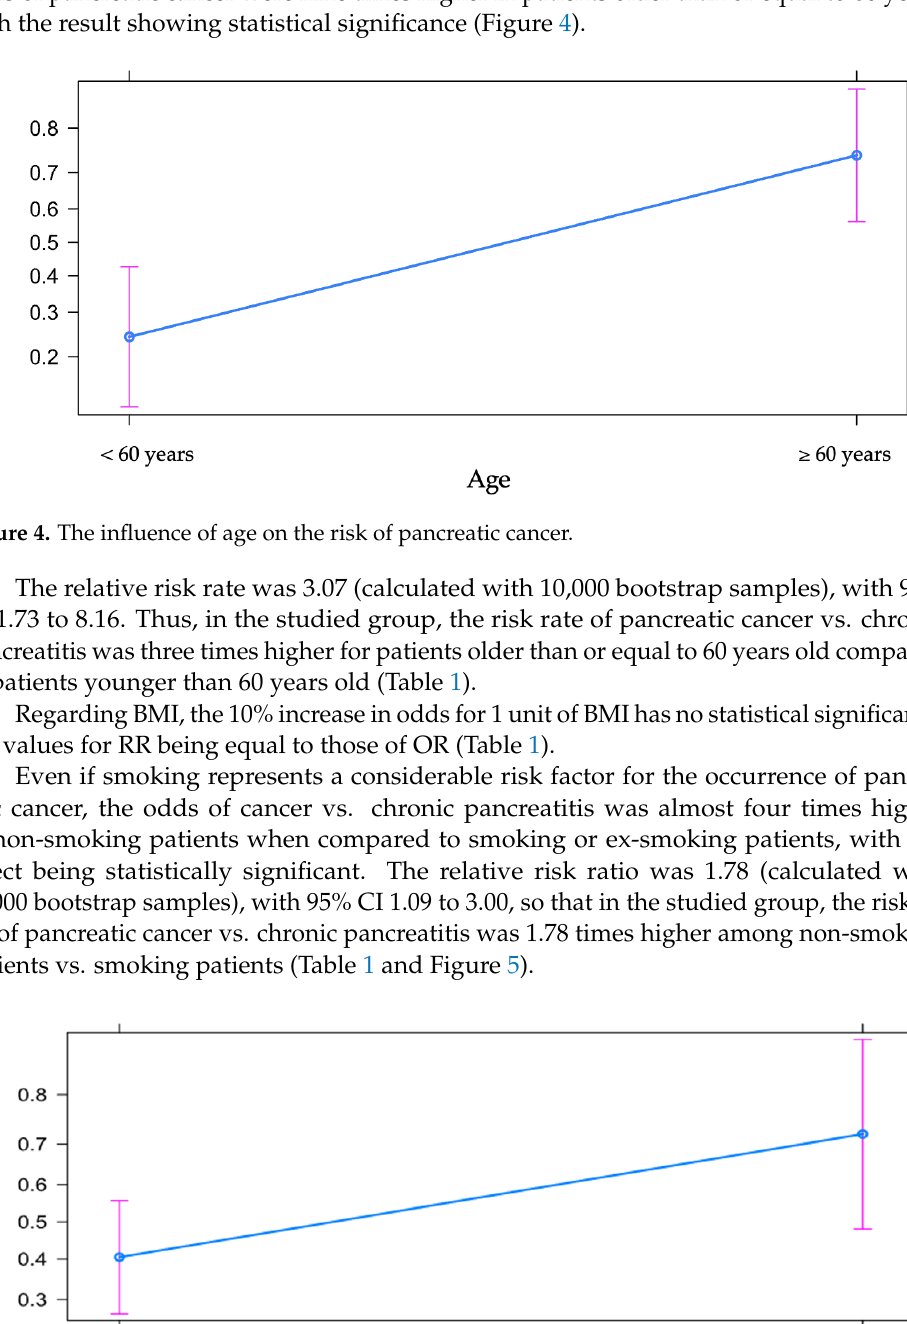
Figure 3. ROC analysis of pancreatic cancer vs. age.